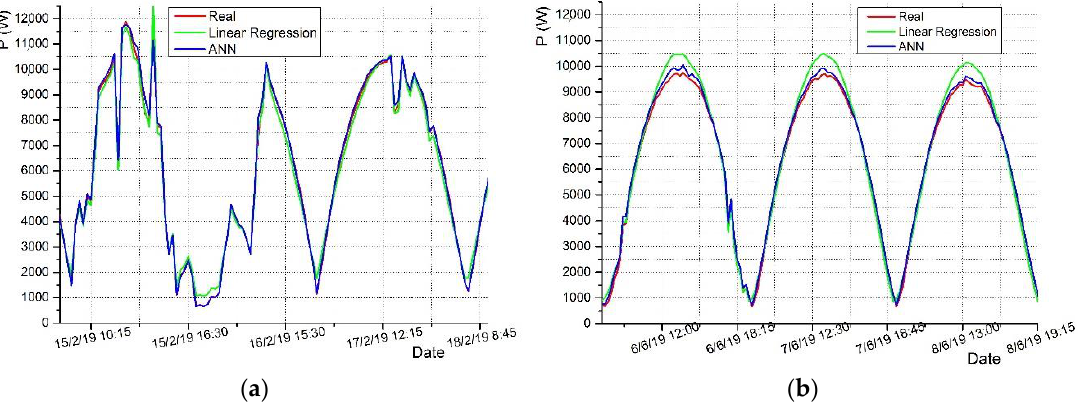
Figure 12. Comparison between actual power output and the one forecasted by the two models, for three cloudy ( a ) and three sunny days ( b ) for 2019.